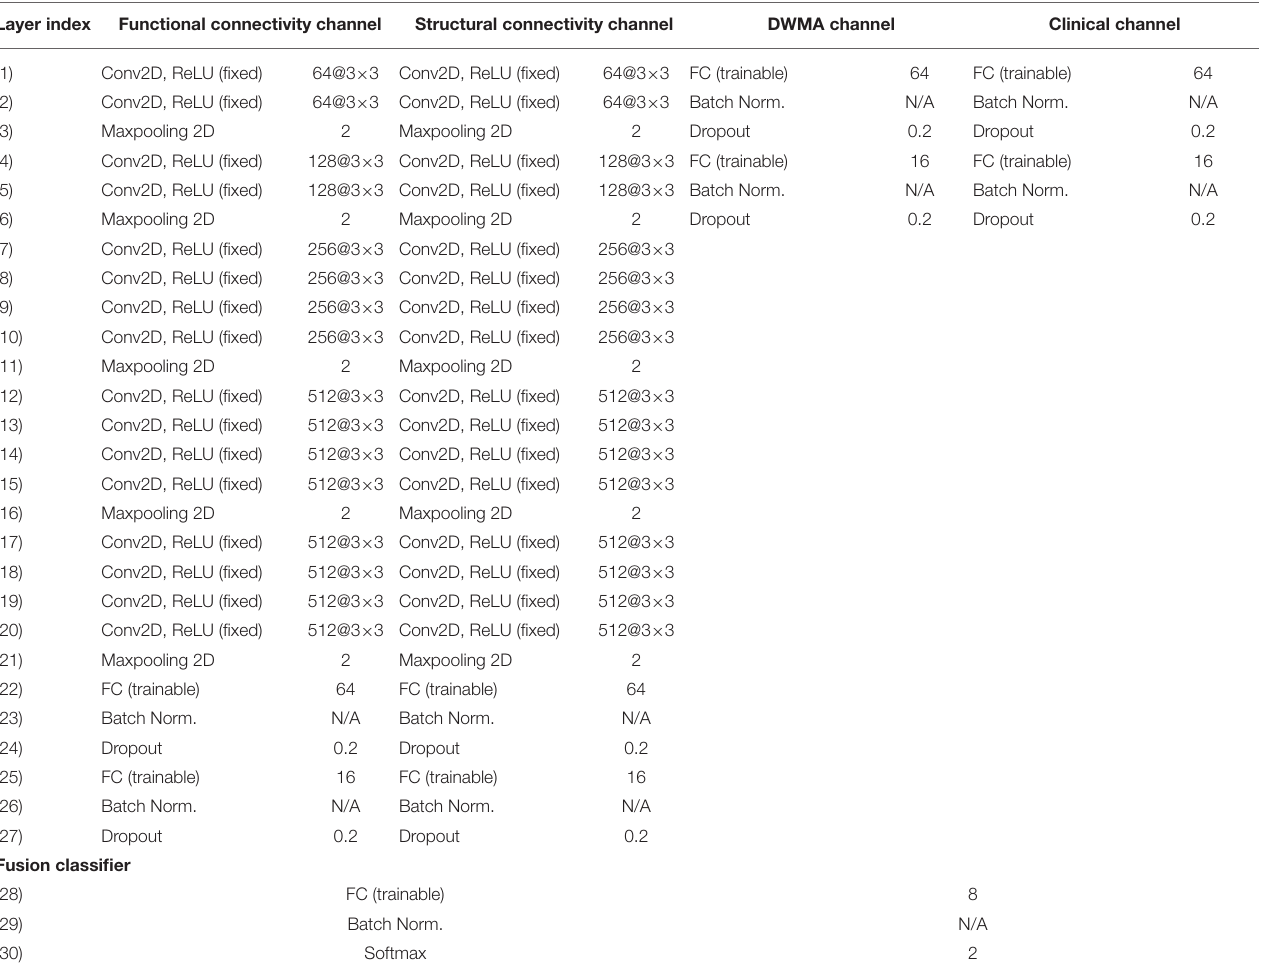
TABLE 1 | Architecture of the proposed deep multimodal learning model.